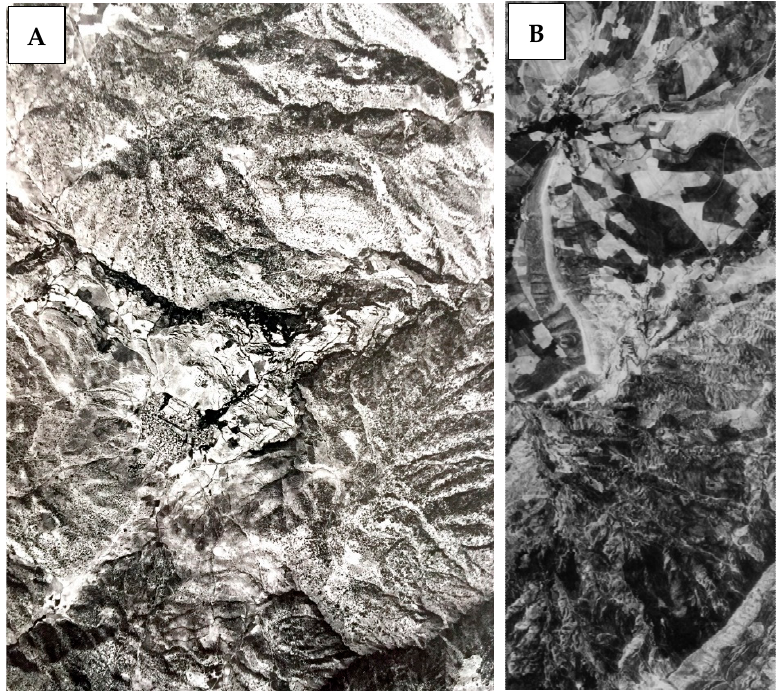
Figure 2. Example of a 1955 aerial photo ( A ) and a Corona film strip ( B ) in DS1103-1041 Corona Image from 4 May 1968.